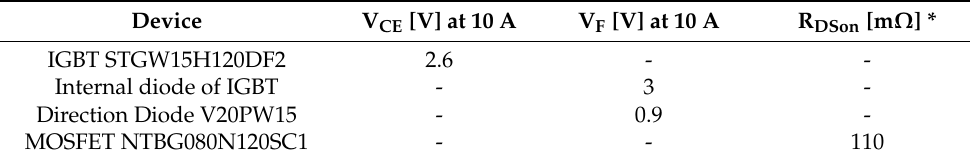
Table 3. Parameters of the semiconductors used in the simulations.